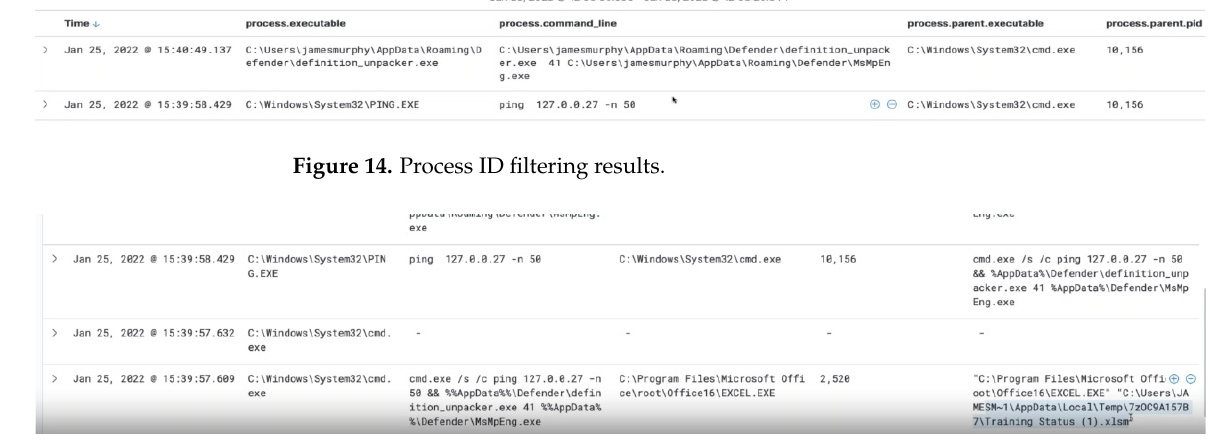
Figure 15. Process ID filtering results (logs).